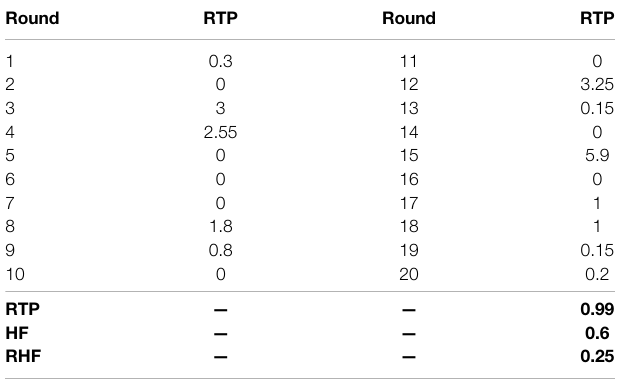
TABLE 2 | Overview of the seed